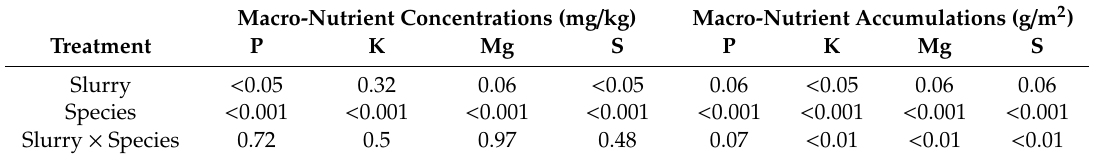
Table 6. ANOVA values for e ff ect of treatments on macronutrient concentration and accumulation. Macro-Nutrient Concentrations (mg / kg) Macro-Nutrient Accumulations (g / m 2 ) Treatment P K Mg S P